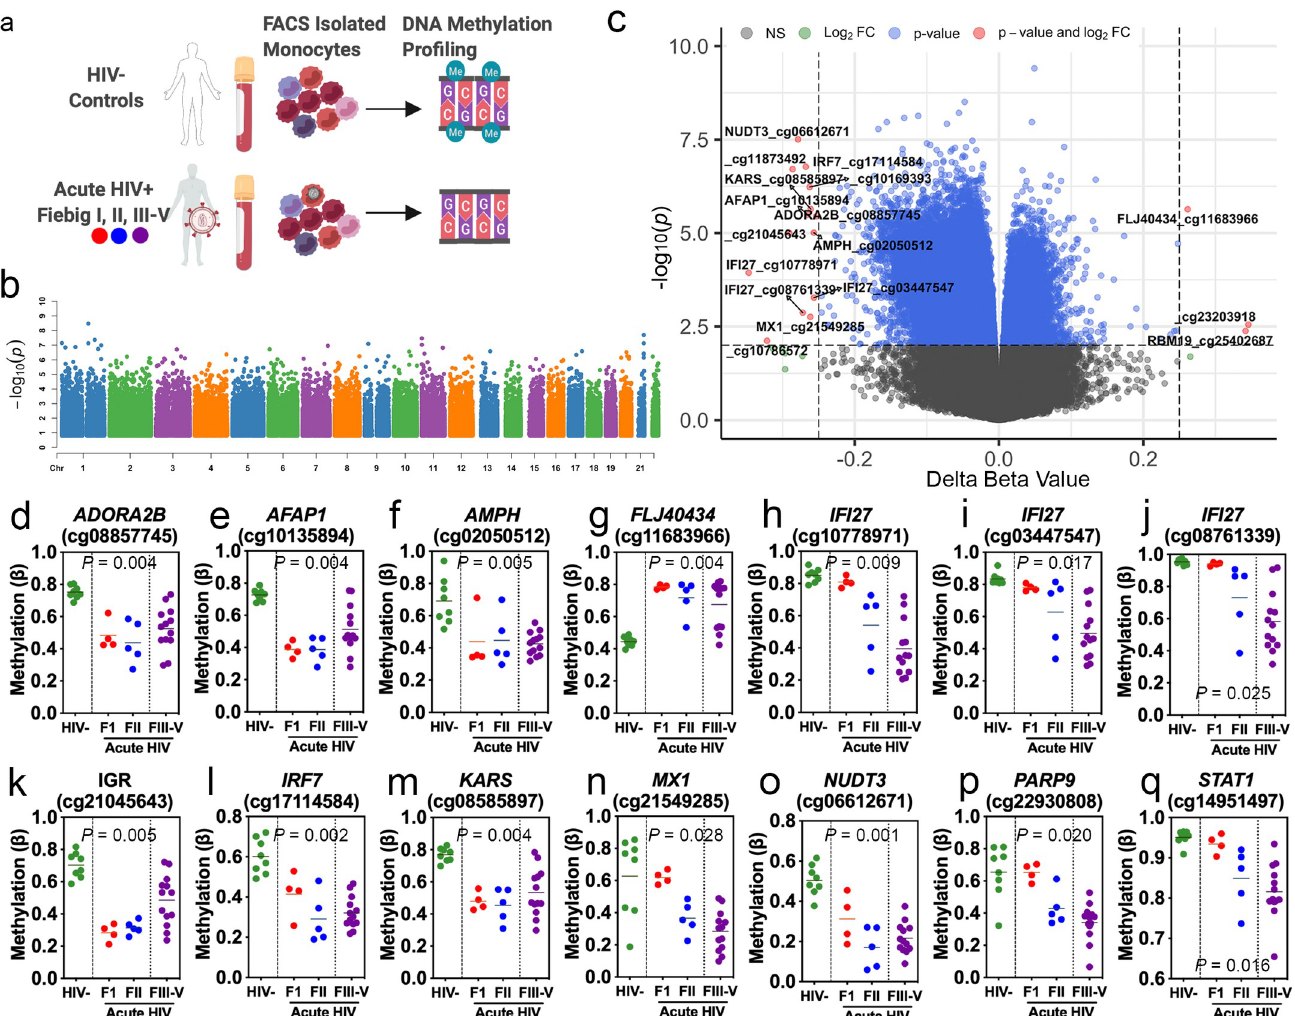
Fig 1. Monocyte cell type-specific differentially methylated loci associated with acute HIV infection. (a) Diagram of experimental design. Created with BioRender.com (b) Manhattan plot of differentially methylated loci associated with AHI in monocytes displayed across chromosomes. P values transformed using -log10(P) (c) Volcano plot displaying HUGO gene symbols and related CpG ID (cg#) for top hypomethylated and hypermethylated sites. Difference in DNA methylation displayed as delta beta values plotted against P values transformed using -log10(P). NS: non-significant. (d-q) Plots demonstrating changes in DNA methylation in AHI Fiebig I (red), Fiebig II (blue) Fiebig III-V (purple) compared to HIV- (green) at single CpGs sites related to specific genes or intergenic regions of the genome displayed in bold italic above CpG ID (cg#). Significance determined comparing HIV- vs. AHI and using FDR adjusted P-values < 0.05.